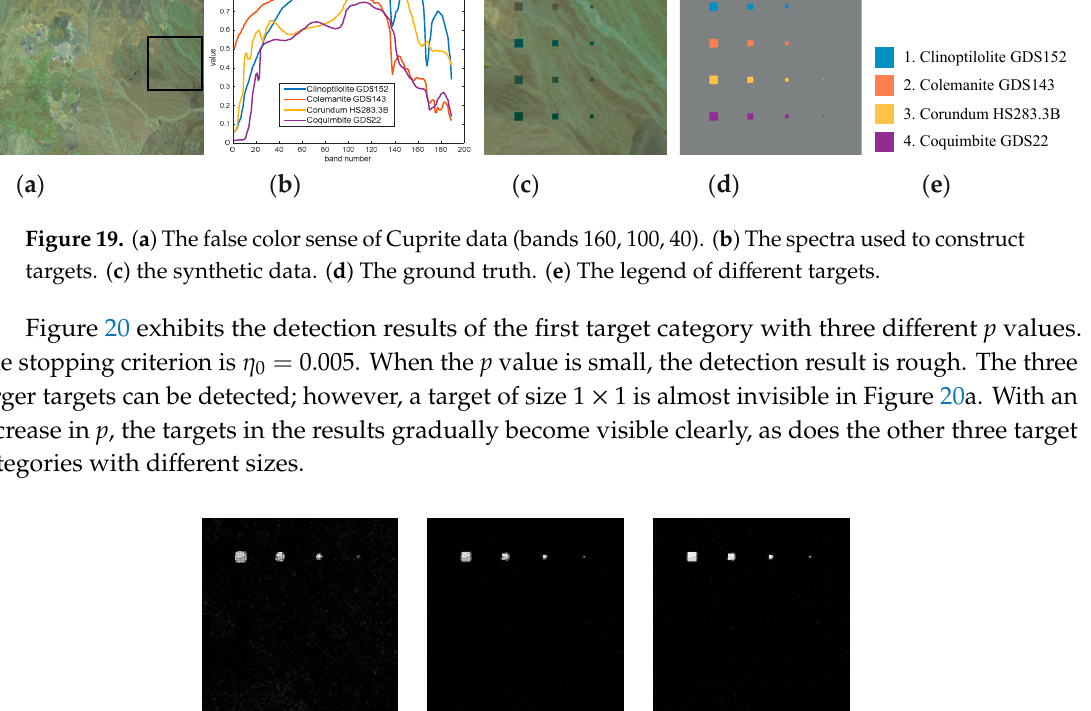
Figure 20. The detection results of the first target with different p values ( a ) p = 1. ( b ) p = 5. ( c ) p = 9.